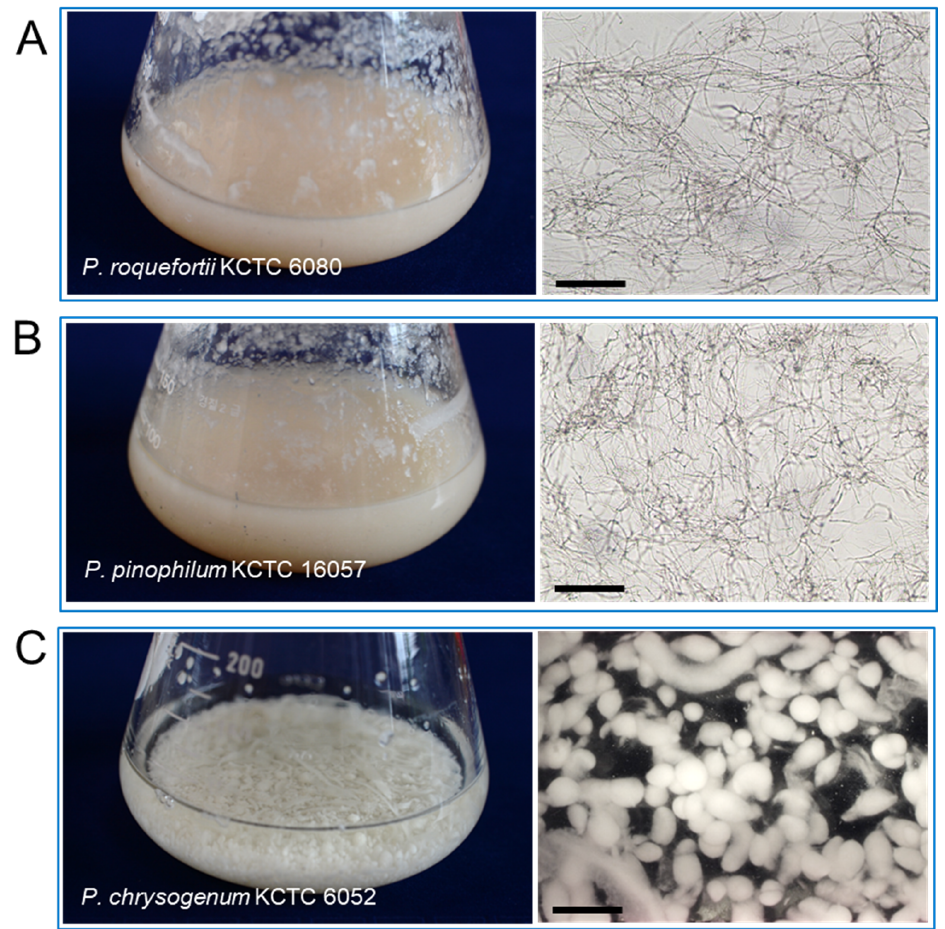
Figure 4. Photos and microscope observation of fungal mycelia grown in a shake flask culture after 2 weeks of culture in PDA liquid medium. ( A ) Photo of P. roquefortii mycelia (left) constituted with homogenous and filamentous mycelia (right) by light microscopy. ( B ) Photo of P. pinophilum mycelia (left) constituted with homogenous and filamentous mycelia (right) by light microscopy. ( C ) Photo of P. chrysogenum mycelia (left) constituted with spherical mycelium pellets (right) by dissecting microscope (right). Bars in ( A , C ) = 50 µm, ( B ) = 700 µm.